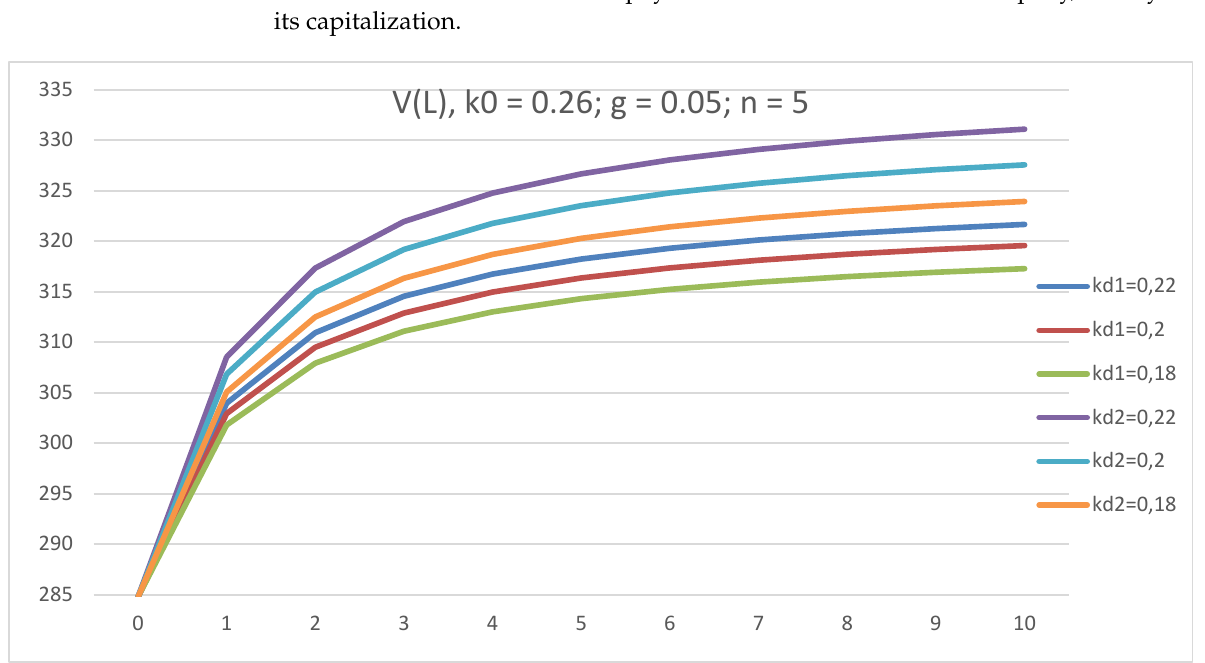
Figure 8. The dependence of equity cost, ke, on leverage level L in GBFO theory with payments of tax on profit at the end of periods (1) and advance payments (2) at k 0 = 0.26; k d = 0.22; 0.2; 0.18 t = 0.2; g = 0.05, for a five year company. 3.3. Influence of Company Age, n, on Main Financial Parameters of the Company